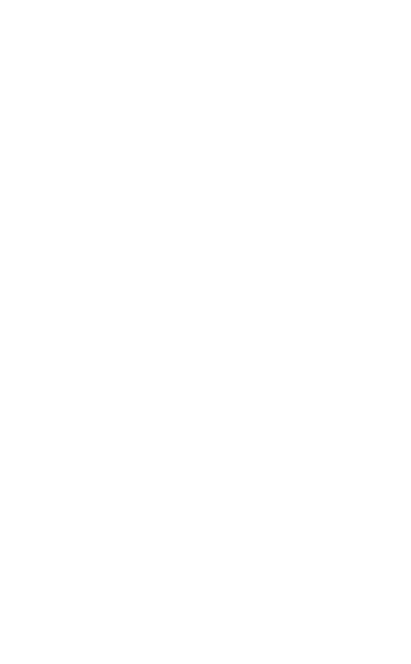
curve was calculated and plotted incorrectly with incorrect description of variables in the Figure Caption of Figure 8. This read ‘ volcanic radiative forcing 41 ; decadal solar irradiance 42 , mean annual insolation at 65°N 48 – 50 , and relative sea level 47 ’ and now reads: ‘ volcanic radiative forcing 41 ; decadal total solar irradiance variations 42 at earth surface ( Δ TSI at the top of the atmosphere × (1 – albedo)/4, with mean albedo =0.29),meanannualinsolationat65°N 48 – 50 , and relative sea level 47 ’ . This has been corrected in both the PDF and HTML versions of the